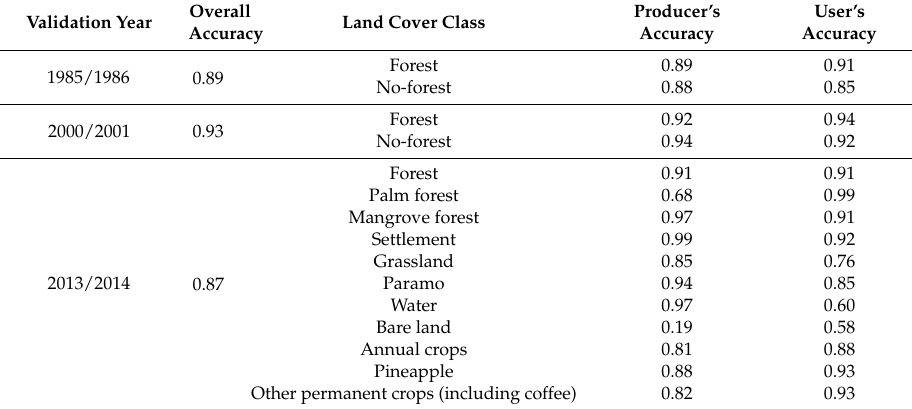
Table 3. Validation of the Land Cover (LC) classification in Costa Rica for the years 1985/1986, 2000/2001 and 2013/2014. These dataset was mainly provided by the National Biodiversity Institute from Costa Rica (INBio) and is considered as a valid ground truth by the Government of Costa Rica.